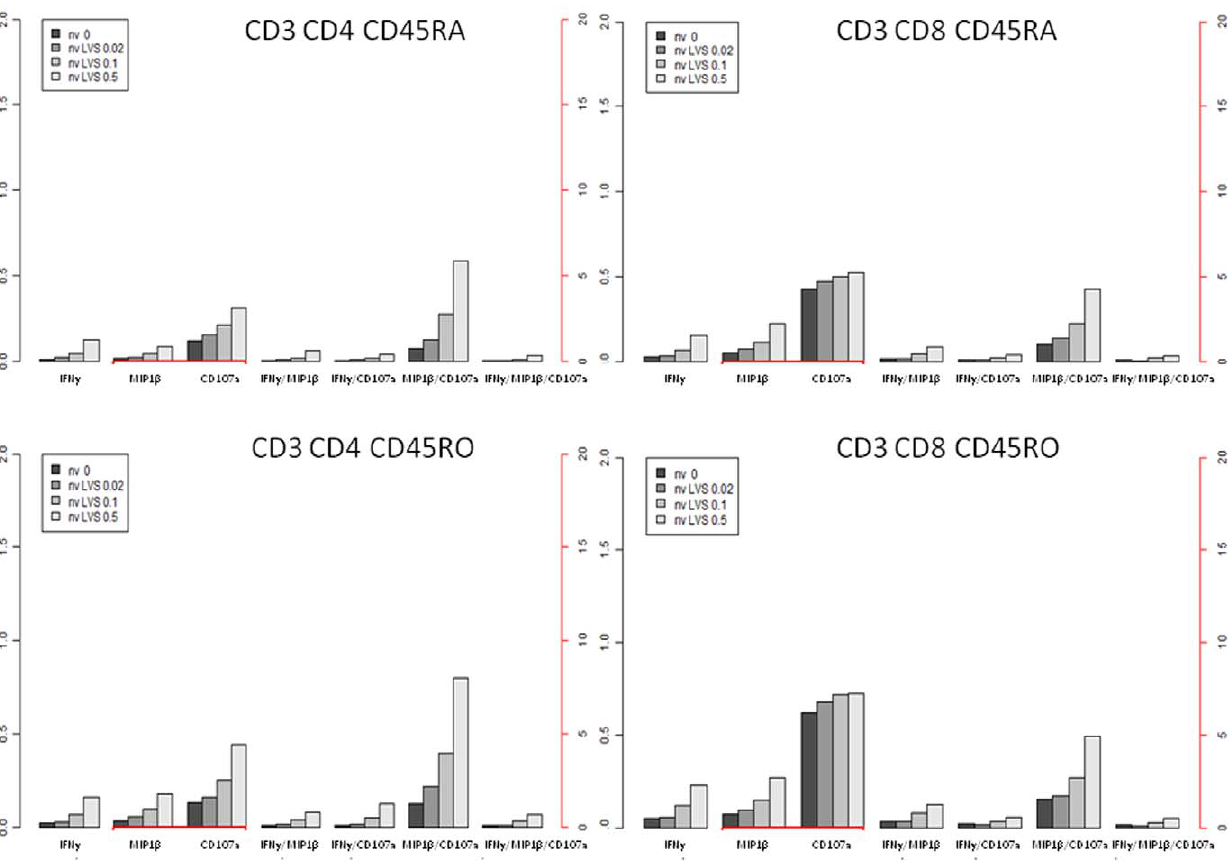
Figure 4. Histograms indicating the frequency of mono-, bi- and tri-functional cell subsets in CD45RO + and CD45RA + T-cell populations of non-vaccinated individuals. Mean values are illustrated throughout. The black axis indicates percentages for mono-functional IFN- c -positive and all bi- and tri-functional T-cell subsets. The red axis indicates percentages for MIP-1 b - and CD107a-positive mono-functional T cell subsets.